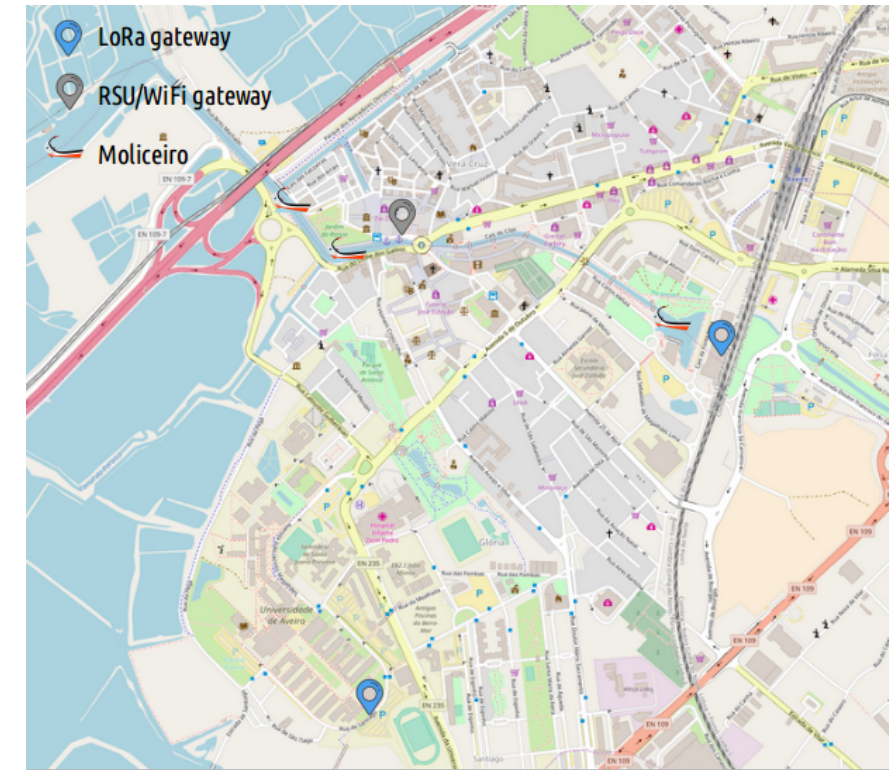
Figure 9. Use case scenario